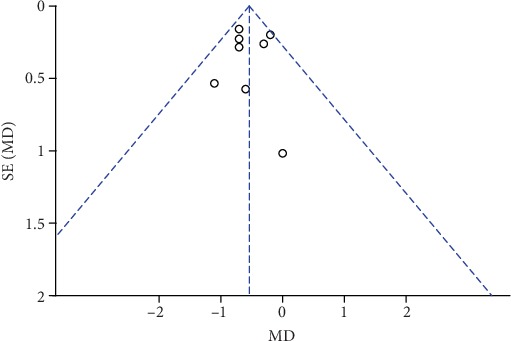
Funnel plot of pain scores at rest at 24 h.